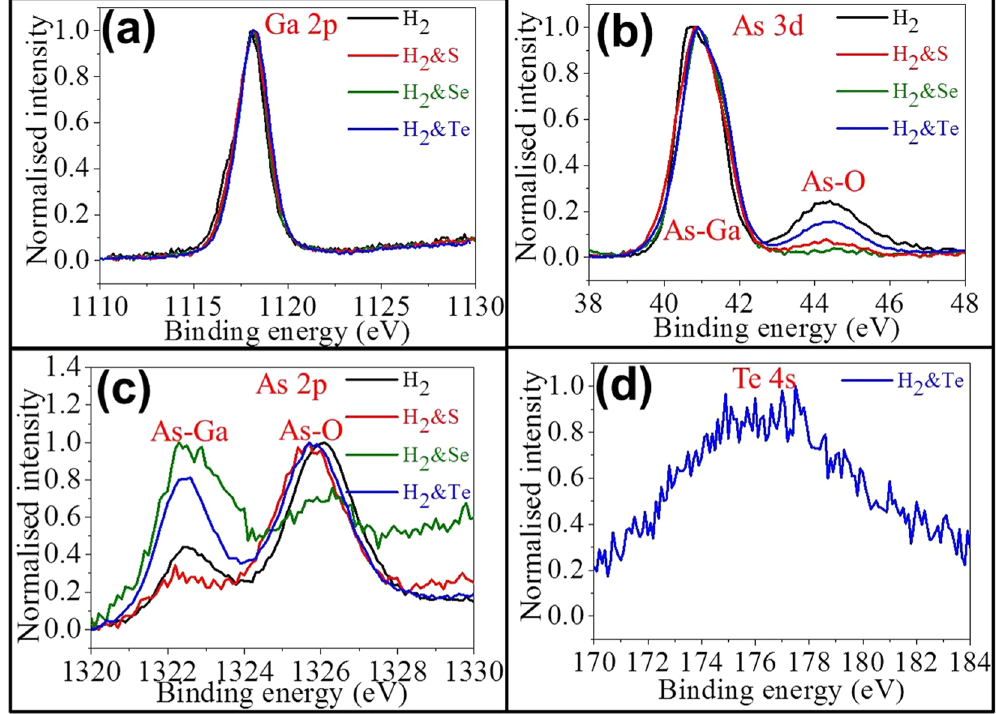
Figure 3. Surface elemental analysis of all as-prepared GaAs NWs. ( a ) Ga 2p bonding region; ( b ) As 3d bonding region; ( c ) As 2p bonding region and ( d ) Te 4 s bonding